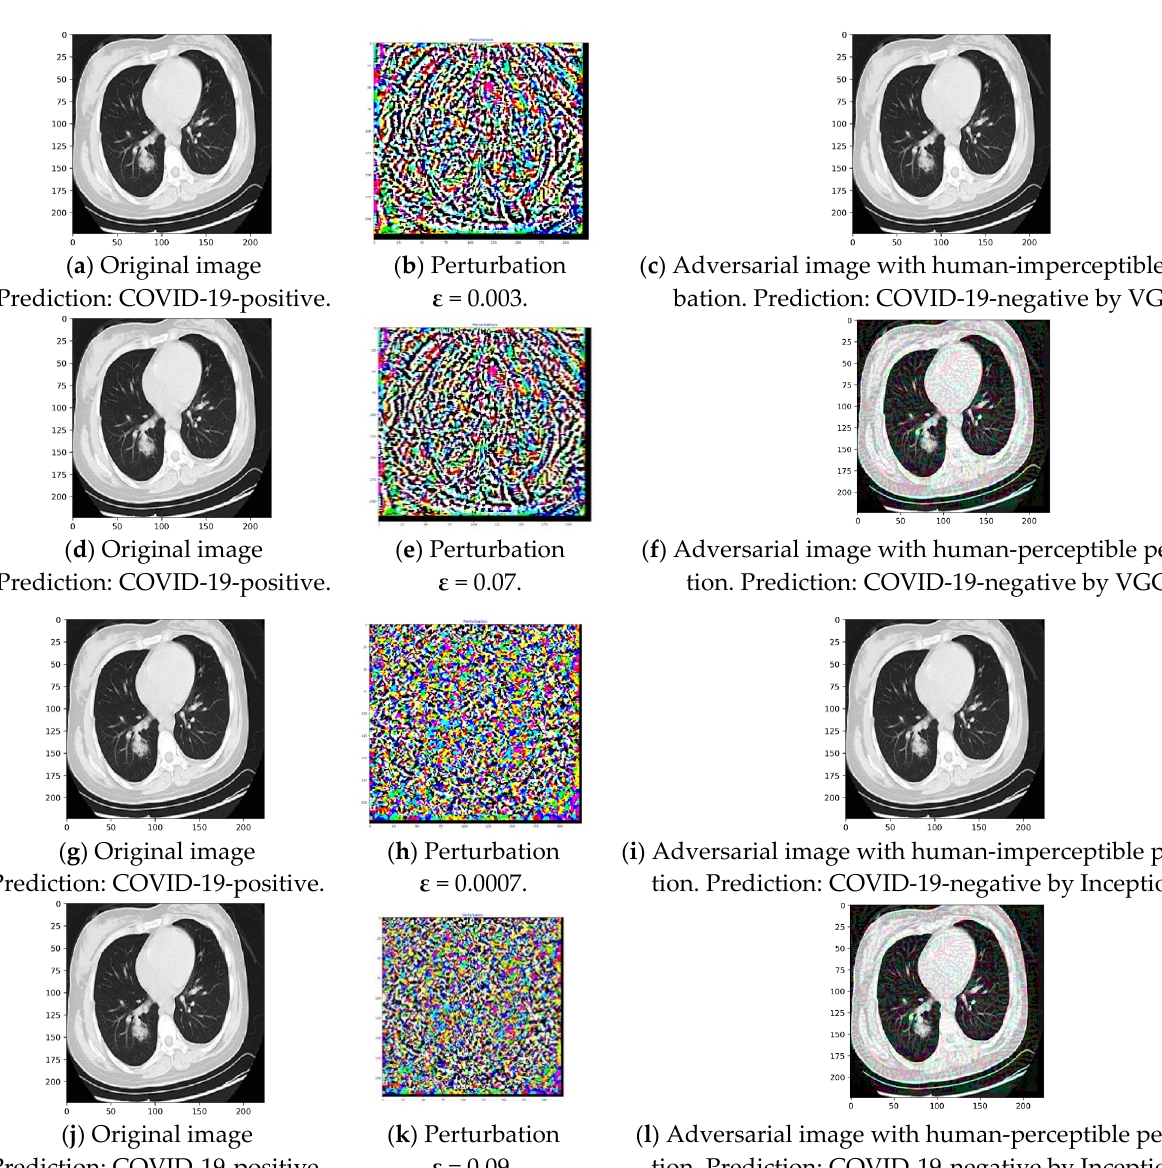
Figure 11. Original image ( left column ), perturbation ( middle column ), and corresponding misclassified adversarial CT images ( right column ) generated by FGSM attack for VGG16 and Inception-v3. Table 8. Diagnostic performance drop for different ε of FGSM attack in chest CT images.